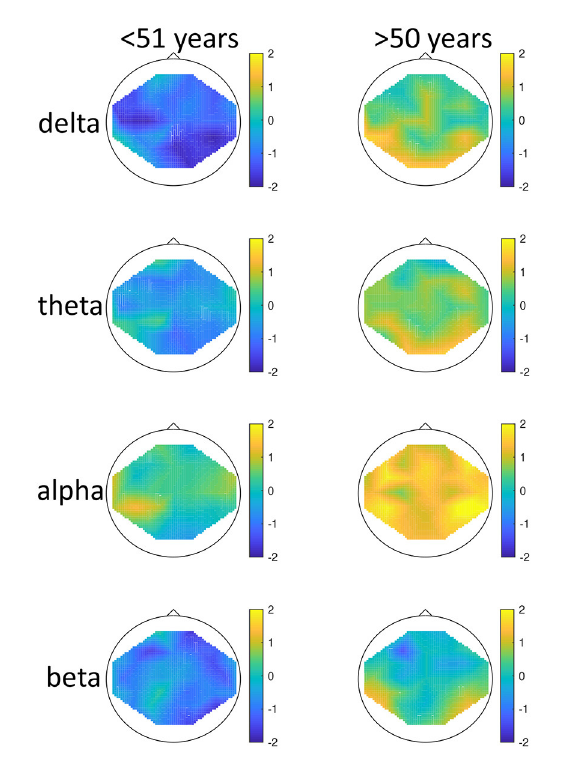
FIGURE1 Topographical maps of activity distribution: colors represent difference between participants with low and high global seasonality score, indicated by approximated z -values from a Wilcoxon rank sum test, for frequency ranges from top to bottom : delta, theta, alpha, beta; and for age groups < 51 years (left) and > 50 years (right) . Negative z -values indicate lower activity in the low- compared to high-seasonality group, positive z -values indicate higher activity in the low- compared to high-seasonality